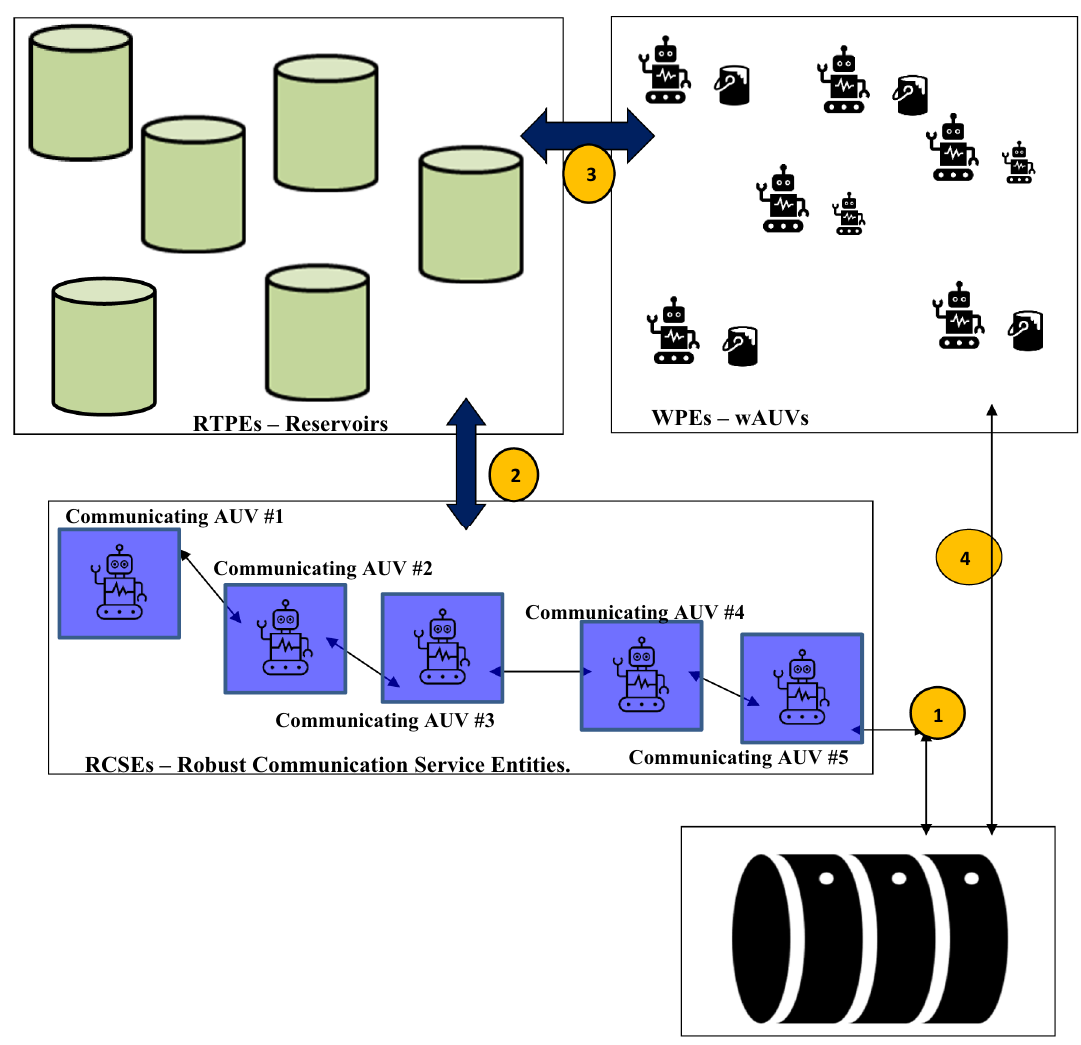
Figure 5. Relations between the RCSEs, RTPEs, WPEs and underwater data centers. (The Figure has been created by AA Periola using Microsoft Word, the logos and objects have been obtained from the Shapes, and Icons options in Microsoft Word).